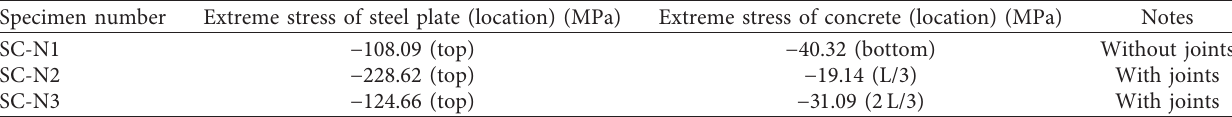
Table 4: Extreme stress of compressive experiment